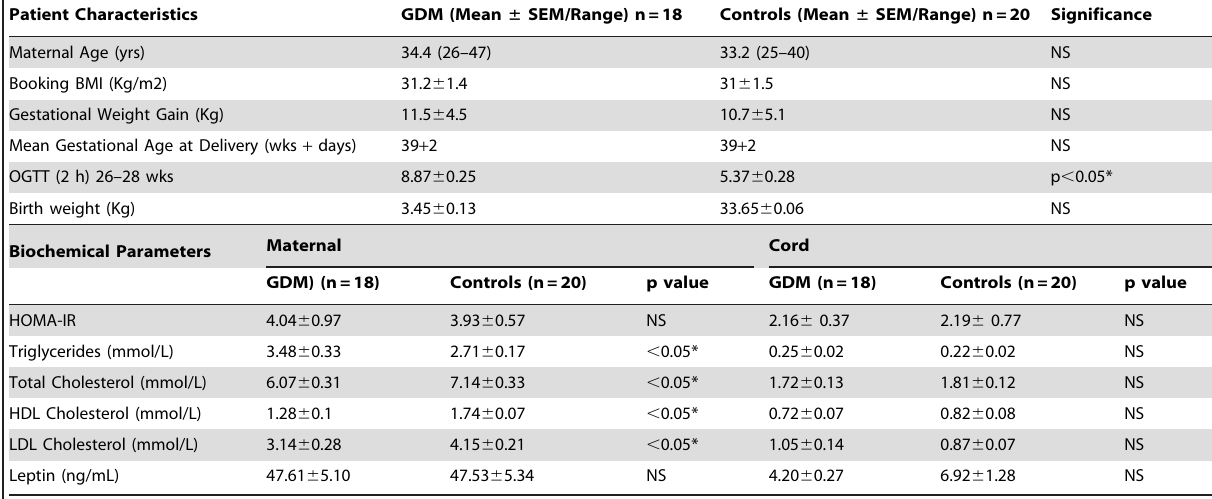
Upper Panel : Clinical characteristics of GDM and controls utilized in this study. (OGTT= Oral glucose tolerance test, NS= Non-significant, p , 0.05* = statistically significant). Lower Panel : Biochemical profiles of maternal and cord blood from GDM and controls at delivery. (HDL= High density lipoproteins, LDL= Low density lipoproteins, HOMA-IR= homeostasis model assessment of insulin resistance, p , 0.05*= statistically significant.). *=statistically significant.